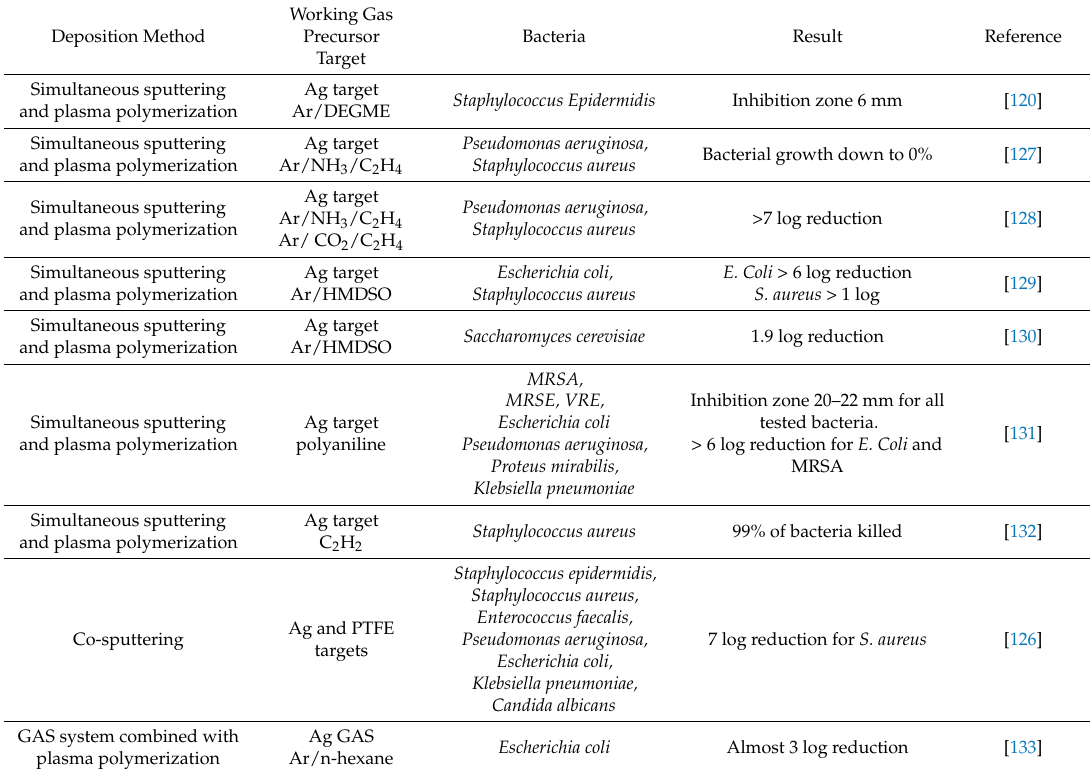
Table 1. Overview of the reported antibacterial effect of Ag/plasma polymer